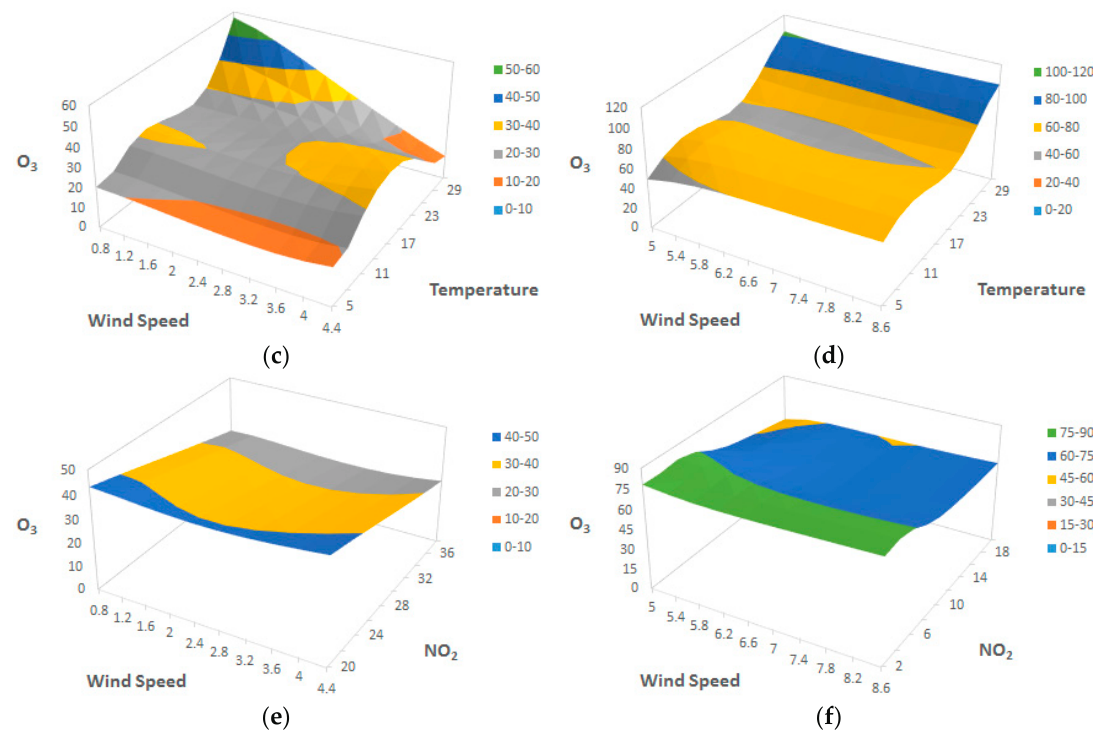
Figure 6. The combined effect of NO 2 concentrations, temperature, and wind speed on O 3 concentrations based on model determined in Simulation I where WS (wind speed) ≤ 4.9 m·s − 1 ( a , c , e ) and where WS > 4.9 m·s − 1 ( b , d , f ).